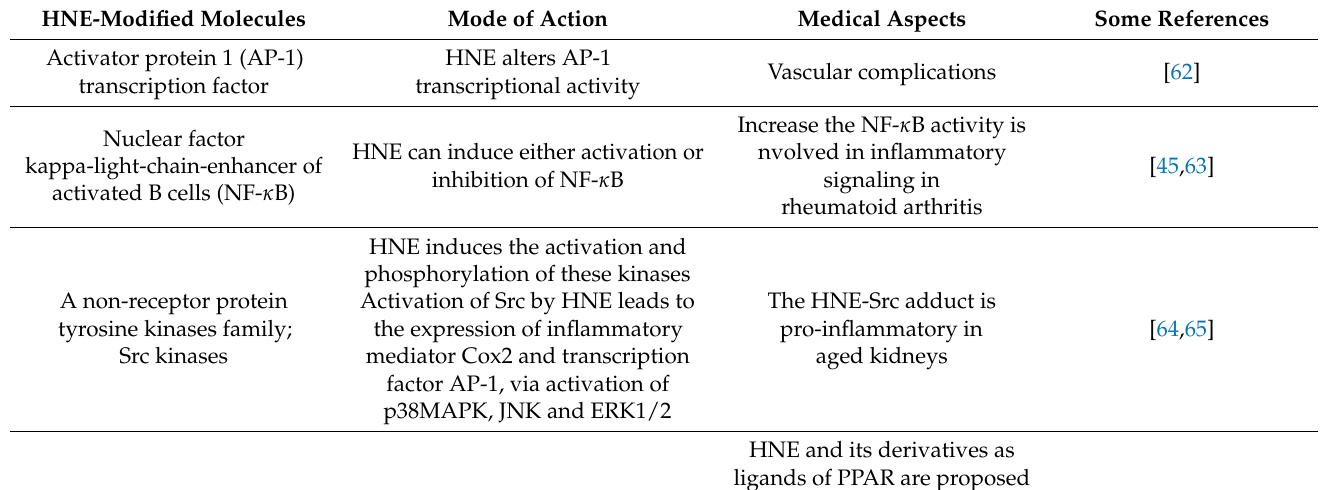
Table 1. Importance of some HNE-modified proteins for practical clinical